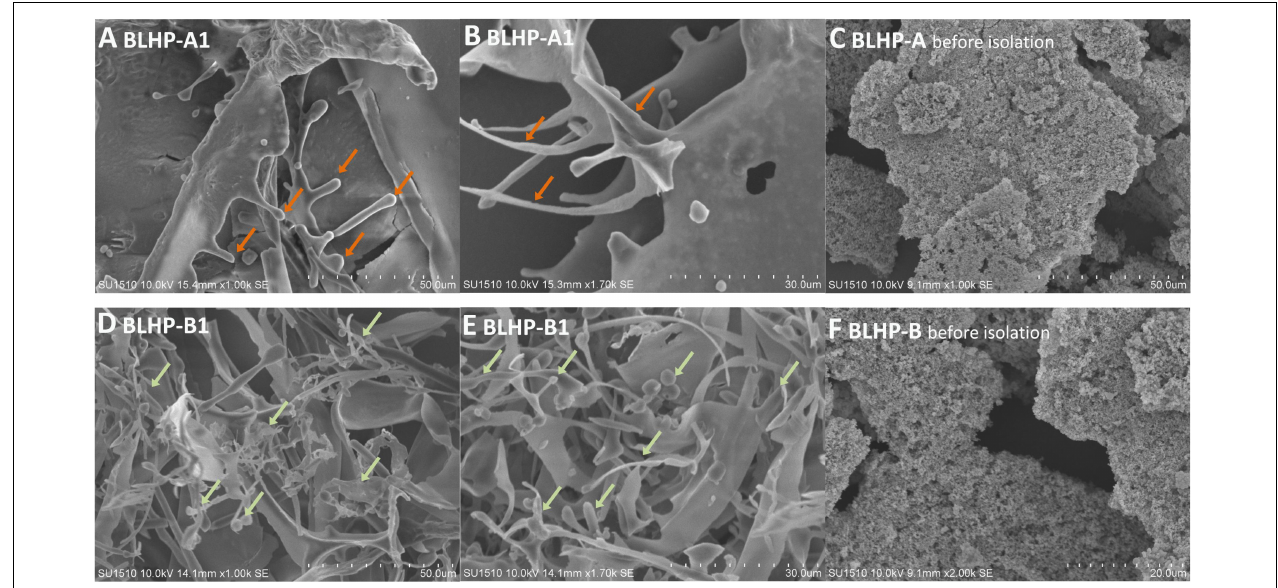
FIGURE 3 | The morphologies of polysaccharides extracted from bamboo leaves. (A,B) Represent BLHP-A1 fraction after being purified by DEAE-Sepharose fast-flow column. (D,E) Illustrate purified BLHP-B1 fraction by DEAE-Sepharose fast-flow column. (C,F) Are the morphologies of BLHP before further purification.